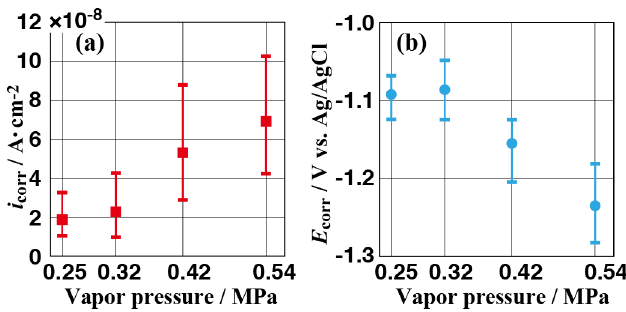
Figure 10. Corrosion current densities ( a ) and corrosion potentials ( b ) determined from the experimental potentiodynamic curves for all samples.